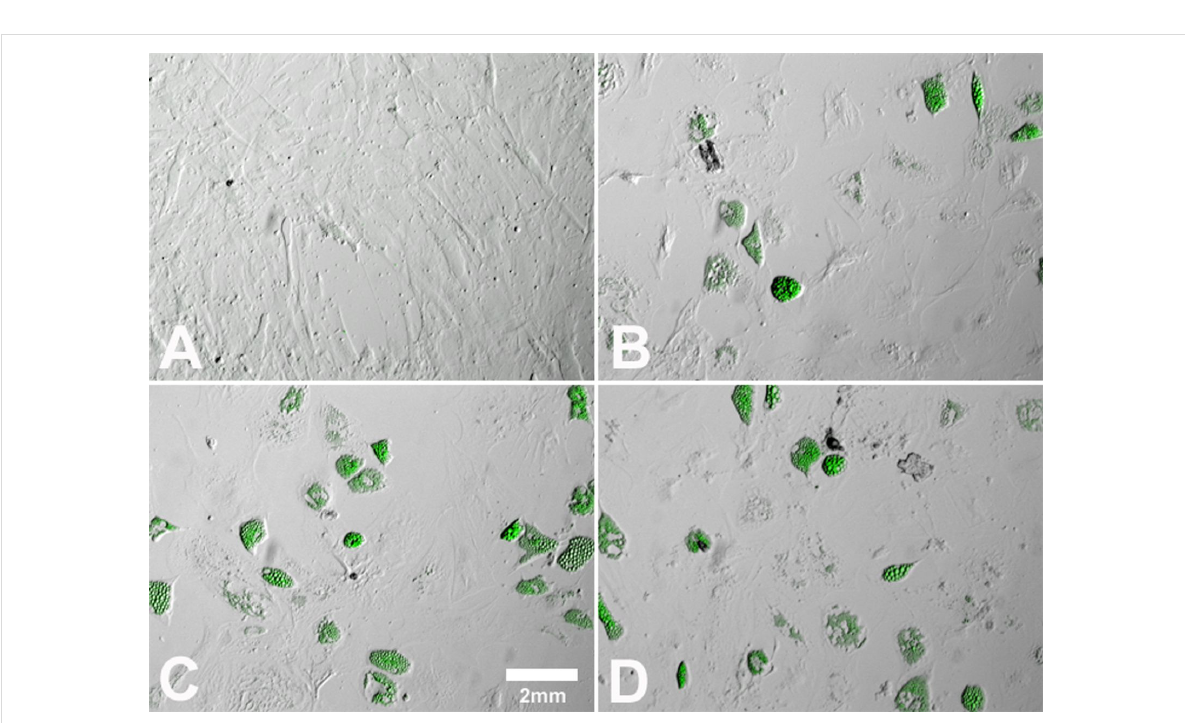
Figure 3: Influence of Ag-NP/ Ag + ions on the adipogenic differentiation of hMSCs. After 14 d of cell culture (bright-field and fluorescence images), Bodipy 493/503 staining was used to visualize lipid vacuoles in cells cultured under adipogenic conditions. hMSCs incubated in the presence of RPMI/ 10% FCS served as a negative control (A). hMSCs incubated in the presence of adipogenic-differentiation media served as a positive control (C). Cells were incubated with 10 µg·mL − 1 Ag-NP (B) or with 1.0 µg·mL − 1 Ag + ions (D) for 24 h and were subsequently incubated with pure adipogenic-dif- ferentiation media for further 14